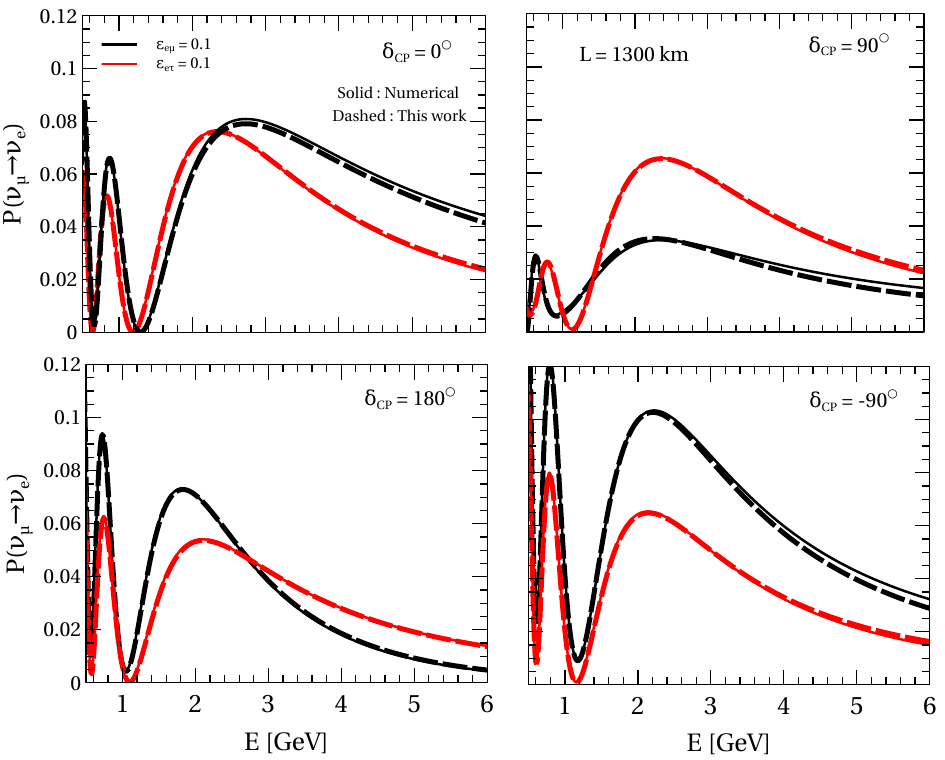
Figure 18 . Comparison of ν µ → ν e appearance probability estimated from our approximate analytical expressions (dashed curves), and the numerical calculations obtained from GLoBES (solid curves) in the presence of NC-NSI parameters ε (black curves) and ε (red curves) in the presence eµ eτ of non-zero δ . We consider our benchmark values of δ : 0 ◦ (upper left panel), 90 ◦ (upper right CP CP panel), 180 ◦ (lower left panel), and − 90 ◦ (lower right panel). We assume L = 1300 km, θ = 45 ◦ , and 23 NMO. The values of the other benchmark three-flavor oscillation parameters are taken from table 2.